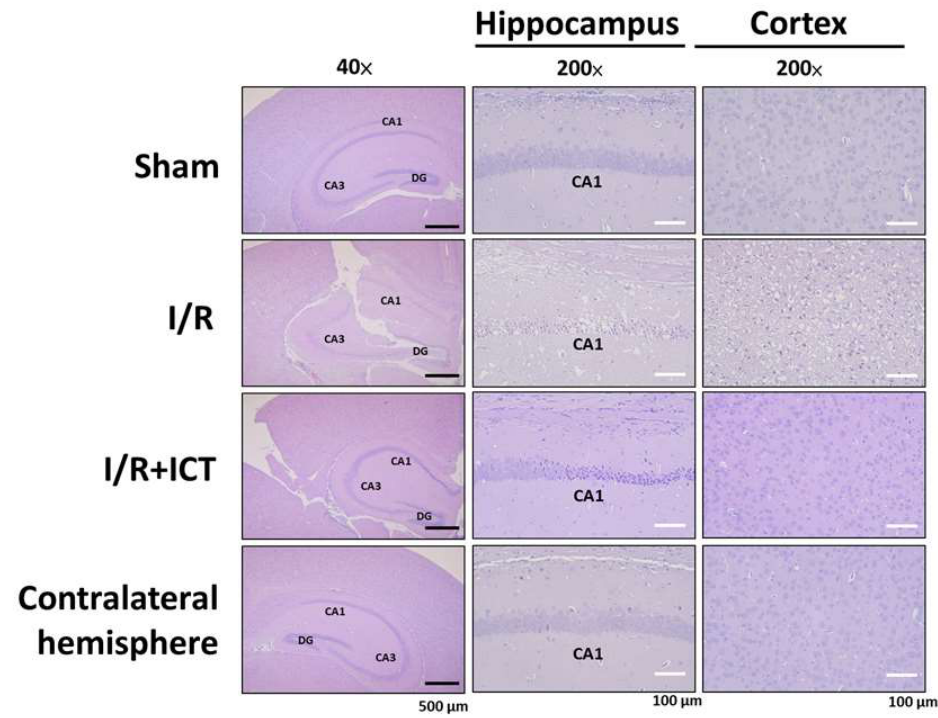
Figure 2. Effects of ICT treatment on histopathological changes in the left cerebral hemisphere of mice with acute cerebral ischemia–reperfusion. H&E staining was used to detect histopathological changes in both the cortex and hippocampus under 40× and 200× magnification. Black scale bar = 100 μm; white scale bar = 500 μm.